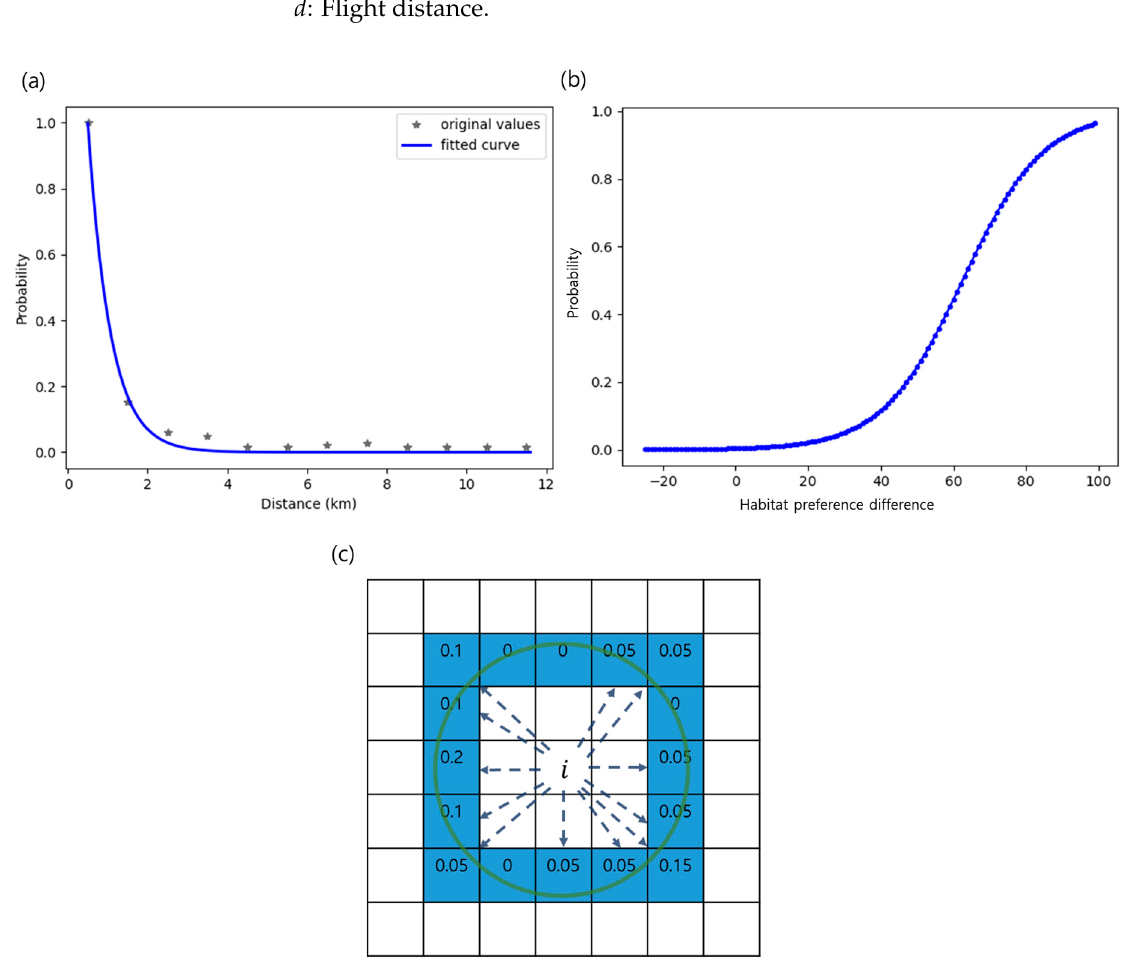
Figure 6. Determining probability of movement distance of the WCSB in the model according to field data ( a ), weight for movement direction based on habitat preference difference compared with the neighbor units ( b ), and probabilistic selection of spatial units according to habitat preference differences (dotted lines indicating probabilistic movement to new spatial units) ( c ).